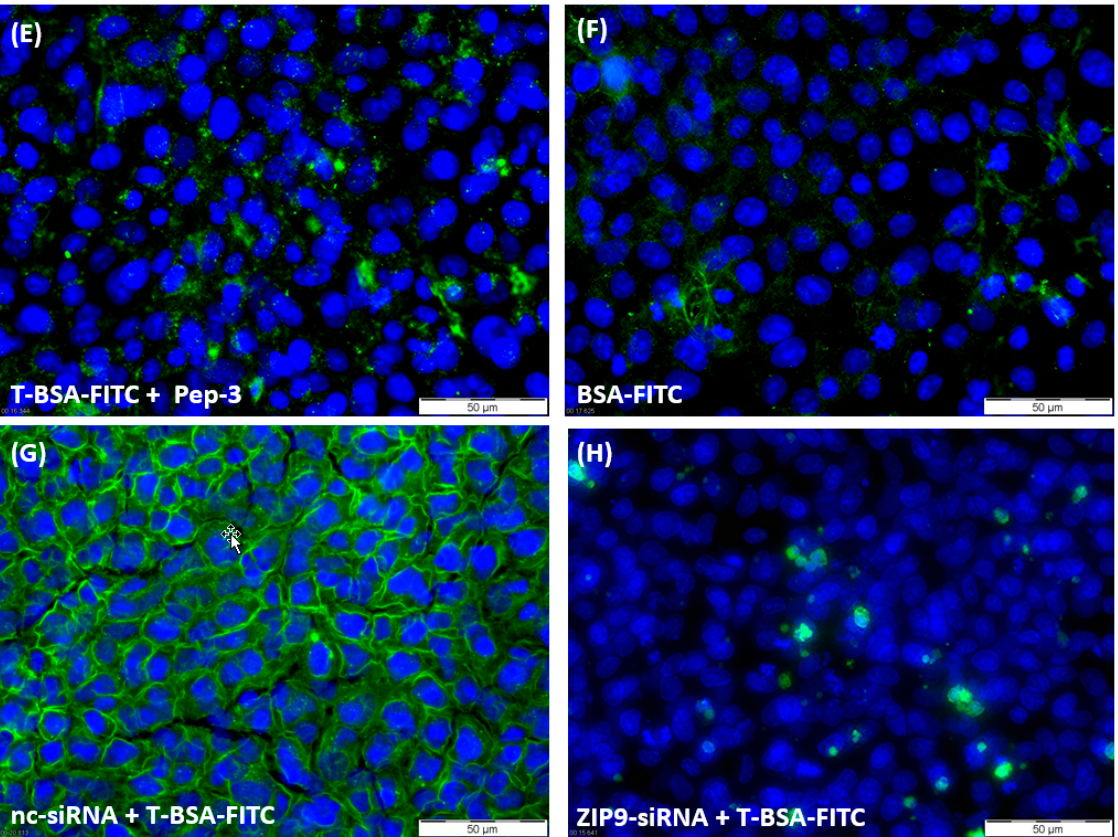
Figure 2. Testosterone-BSA-FITC (T-BSA-FITC) membrane labelling of 93RS2 cells. T-BSA-FITC or BSA-FITC are visualized as green fluorescence, nuclei are stained blue. ( A ) 93RS2 cells were treated with T-BSA-FITC, which leads to distinct membrane labelling. ( B – E ) Testosterone (10 nM) or peptides 1–3 (10 µ M) were added to cells treated with T-BSA-FITC. ( F ) Labelling of 93RS2 cells with BSA-FITC lacking the T moiety. ( G ) The 93RS2 cells were treated with nc-siRNA prior to T-BSA-FITC incubation. ( H ) Cells were incubated with ZIP9-specific siRNA and then treated with